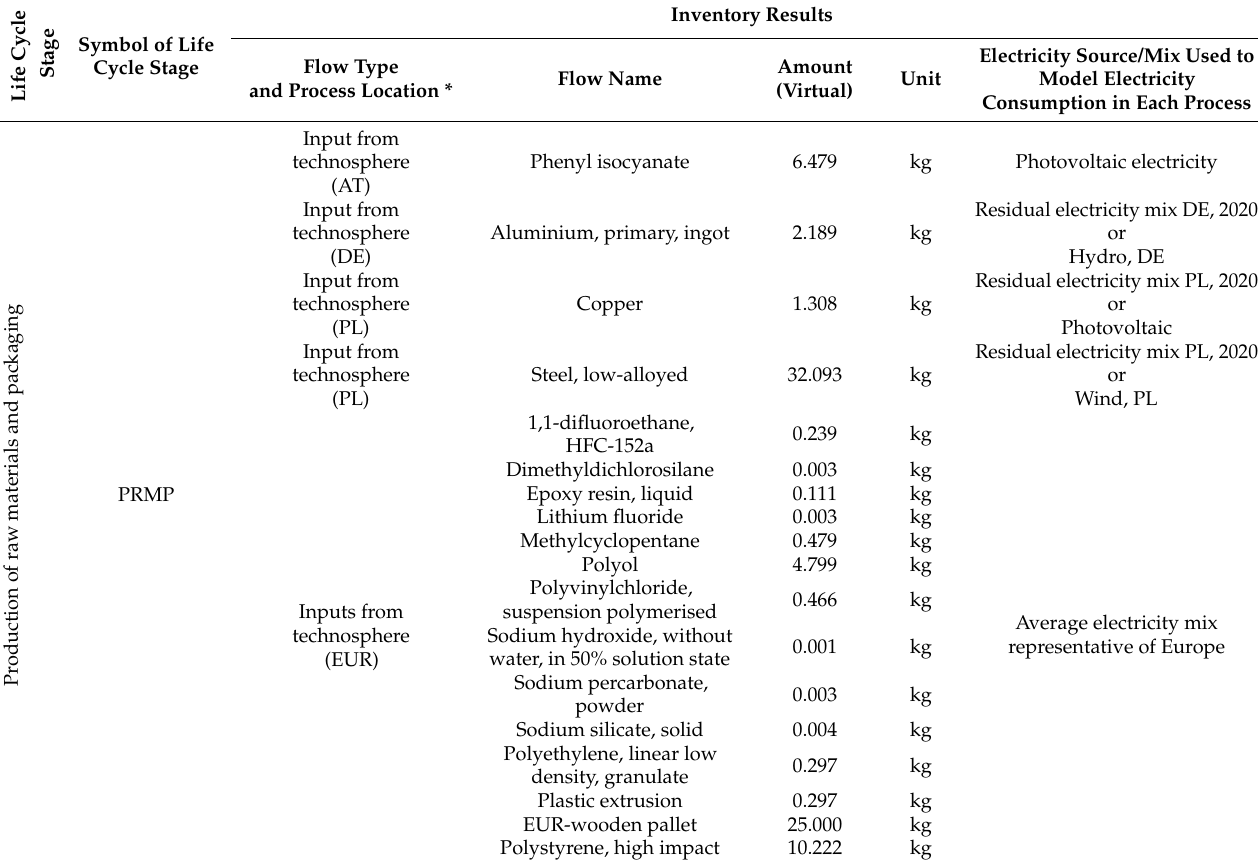
Table 1. Inventory data for the life cycle of the analyzed refrigerator (1